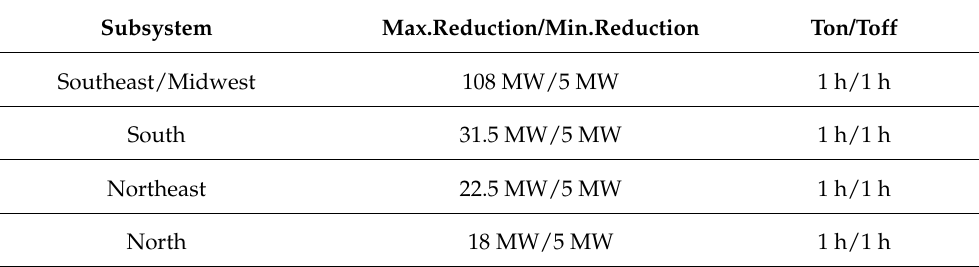
Table 1. Allowed reduction of each DR per subsystem.